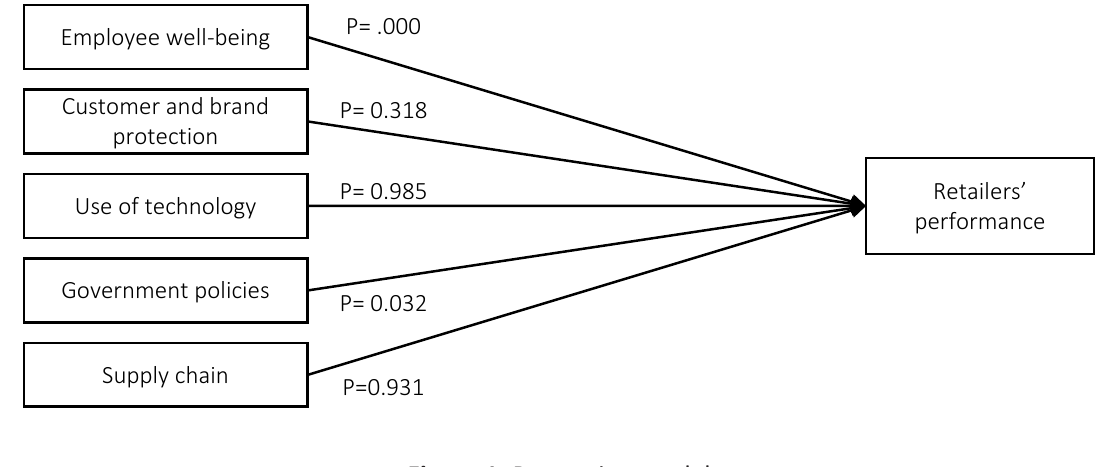
Figure 1. Regression model